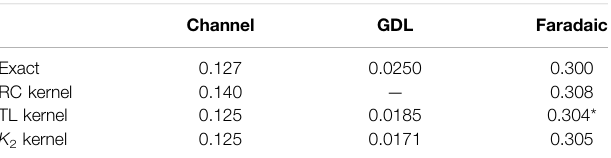
TABLE2| Channel,GDL,andfaradaicresistivities( Ω cm 2 )resultingfromDRT, Eq. 6 . Star p indicates the value calculated as a sum of faradaic and all high- frequency peaks in Figure 4B . The fi rst row shows exact data calculated with Appendix Eqs. A13 .